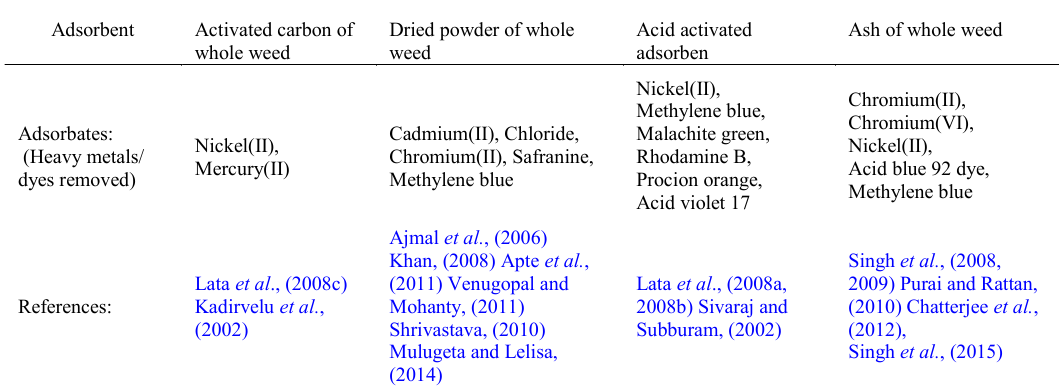
Table 3: Various forms of adsorbents prepared from Parthenium hysterophorus